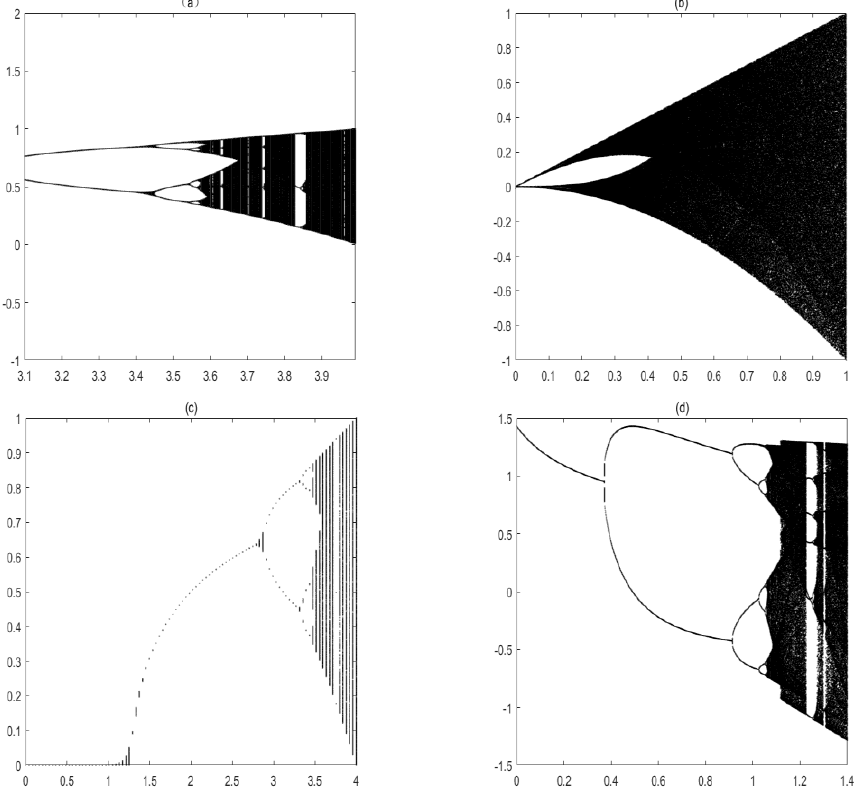
Figure 2. Four common chaotic map bifurcation graphs: ( a ) is the bifurcation graph of the logistic chaotic map; ( b ) is the bifurcation graph of the tent chaotic map; ( c ) is the bifurcation graph of the sine chaotic map; and ( d ) is the bifurcation graph of the Hénon chaotic map.